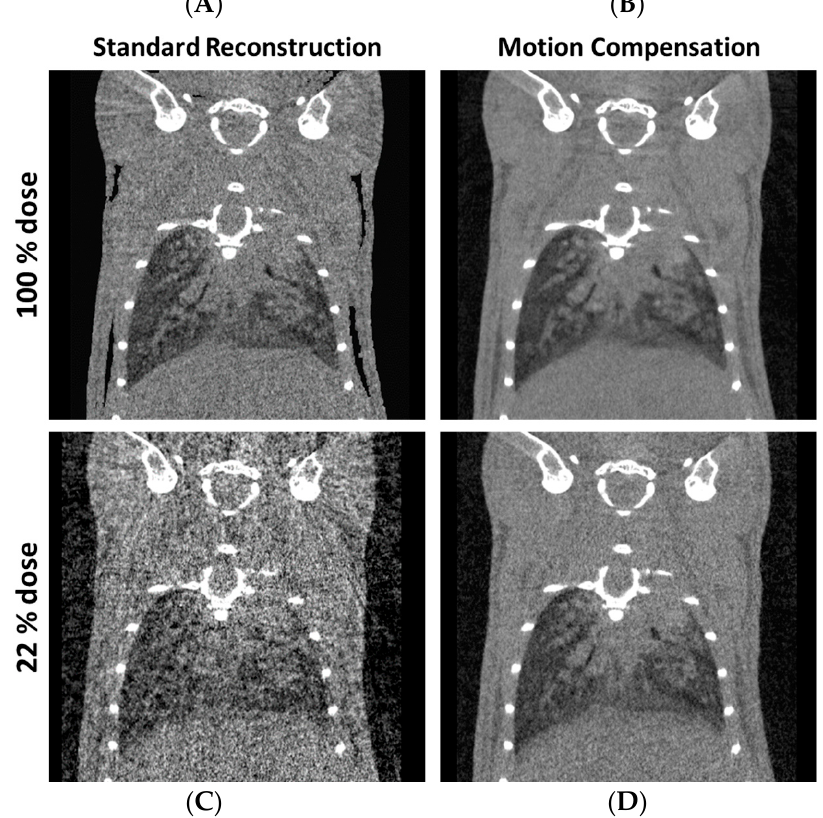
Figure 3. Motion correction of in vivo µ CT to improve image quality and dose exposure. Respiratory-gated 4D µ CT reconstructions of a mouse with a respiratory window width of 20%. The top row shows reconstructions obtained with the full dose of the used reference protocol ( A , B ) and the bottom row shows reconstructions obtained using only 20% of the reference dose ( C , D ). The standard reconstruction (FBP) results in severe artifacts if dose is reduced while a motion compensation (MoCo) approach results in an image quality su ffi cient for most qualitative and quantitative tasks ( D ). (C = 50 HU, W = 400 HU). Videos are available as a supplementary: Video S1a and S1b.